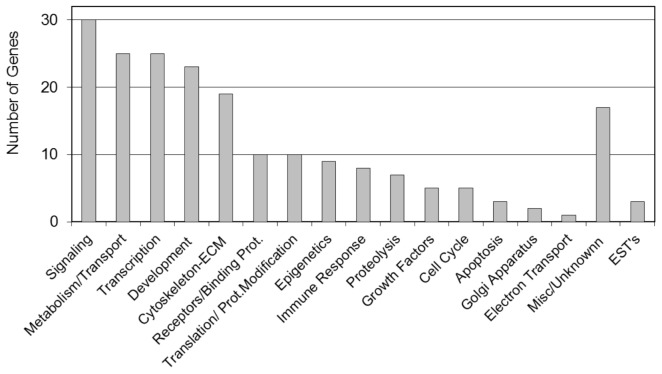
The F3 generation plastics lineage sperm DMR associated gene functional categories.The number of DMR associated genes correlating to a specific gene functional category is presented including those with unknown function and expressed sequence tags (EST).